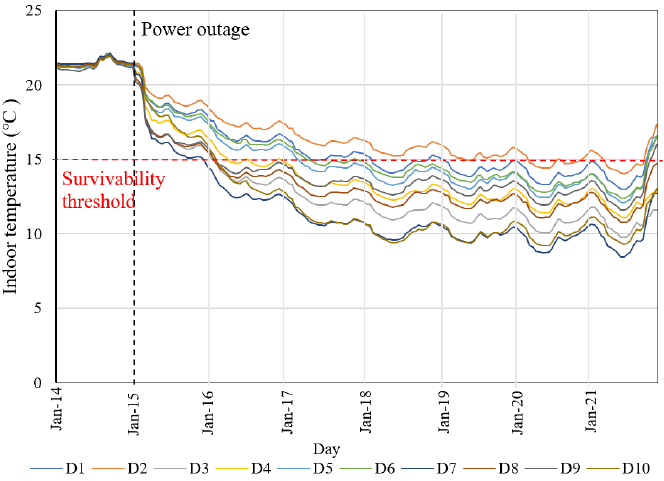
Figure 11. Winter passive survivability performances of the ten designs following a grid power outage in the